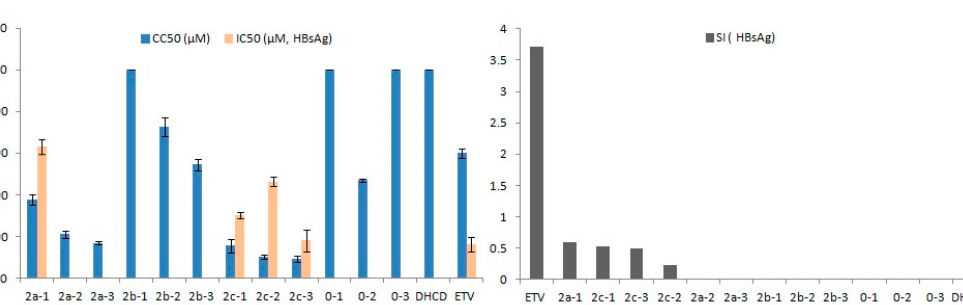
Figure 1. Cytotoxicity, inhibiting HBeAg activity and selectivity index (SI, right) of compounds.